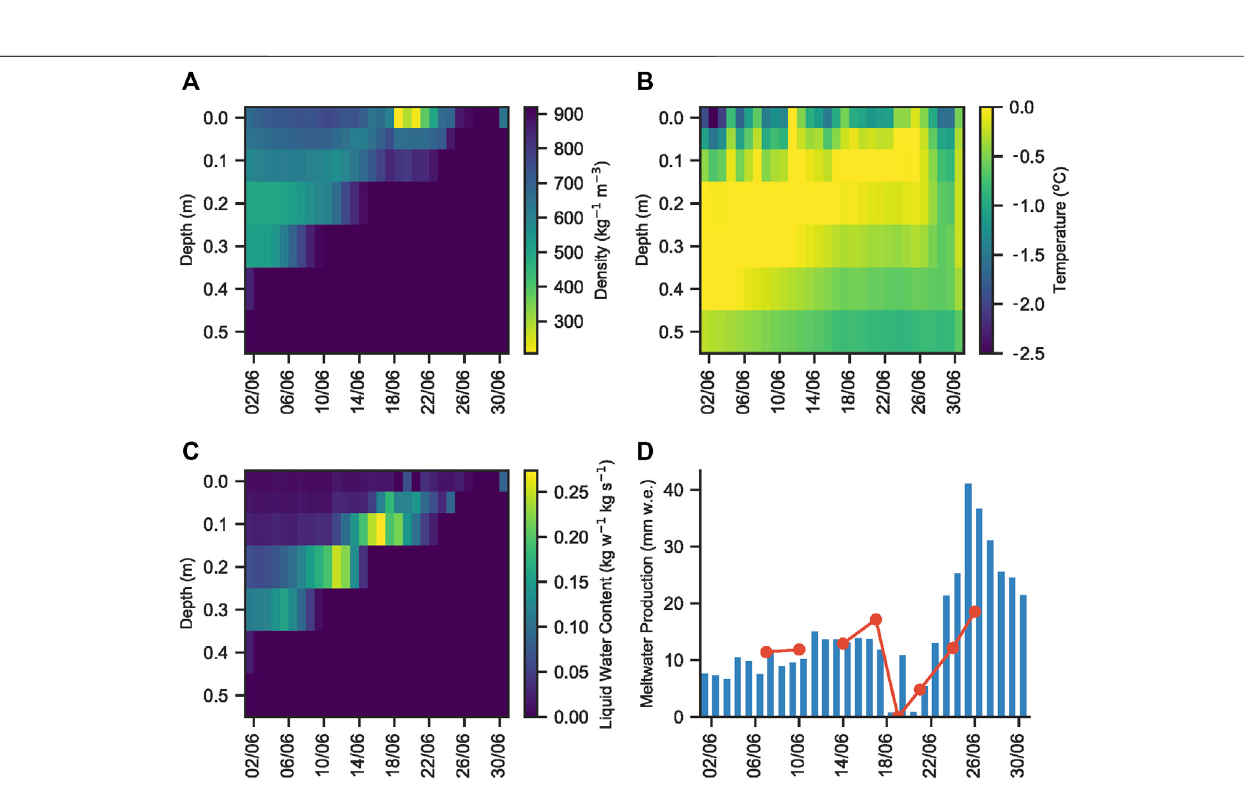
Frontiers in Earth Science |